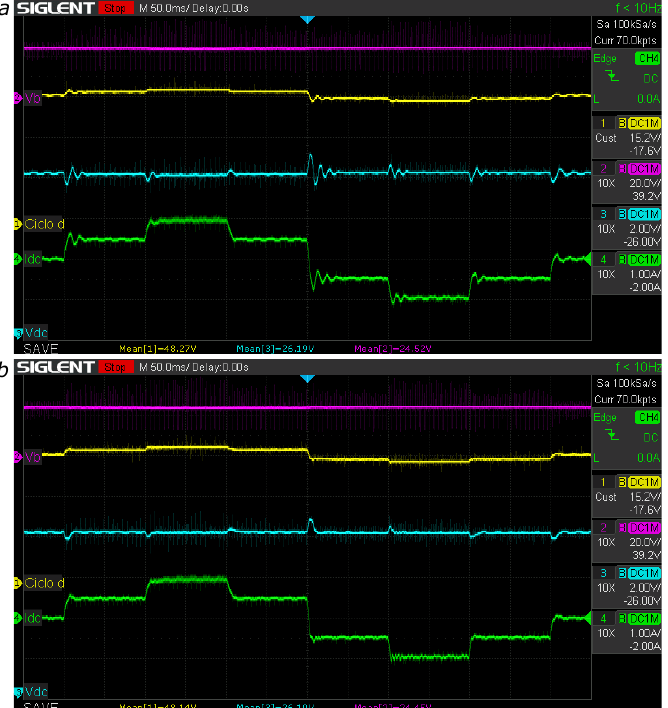
= 26 V (boost mode) using ( a ) PI and ref